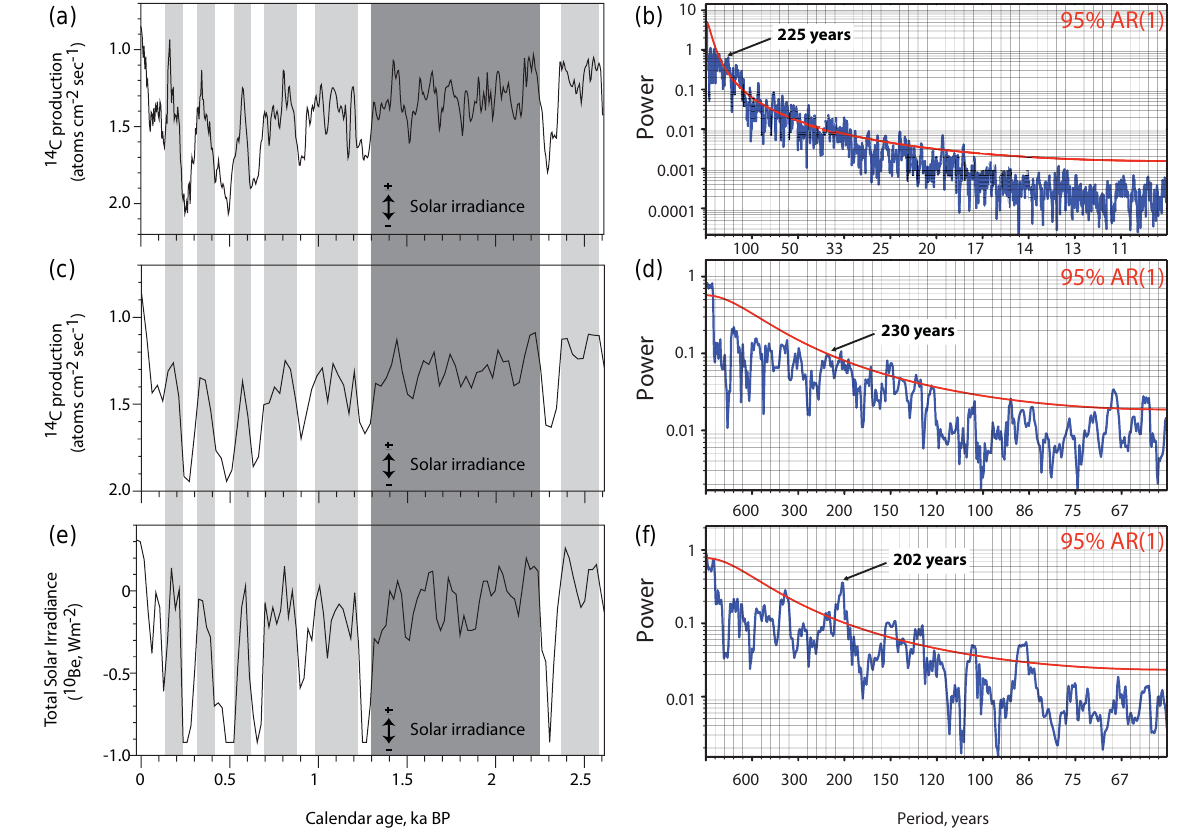
Figure 6. Changes in solar output and multi-taper method (MTM) analysis of reconstructed radiocarbon ( 14 C) production rate (5-year resolution; this study) (Bond et al., 2001; Turney et al., 2005) (a, b) , 14 C production rate (resampled at 30 years) (c, d) , and Total Solar Irradiance (based on polar ice 10 Be) (resampled at 30 years) (e, f) (Steinhilber et al., 2009) for the full length of each record. The dark grey column defines a millennial-duration period of sustained high solar irradiance in all records; the light grey columns define temporary (centennial-duration) periods of high irradiance. The periodicities that fall within the reported range of the de Vries cycle are identified in the MTM panels (200–230